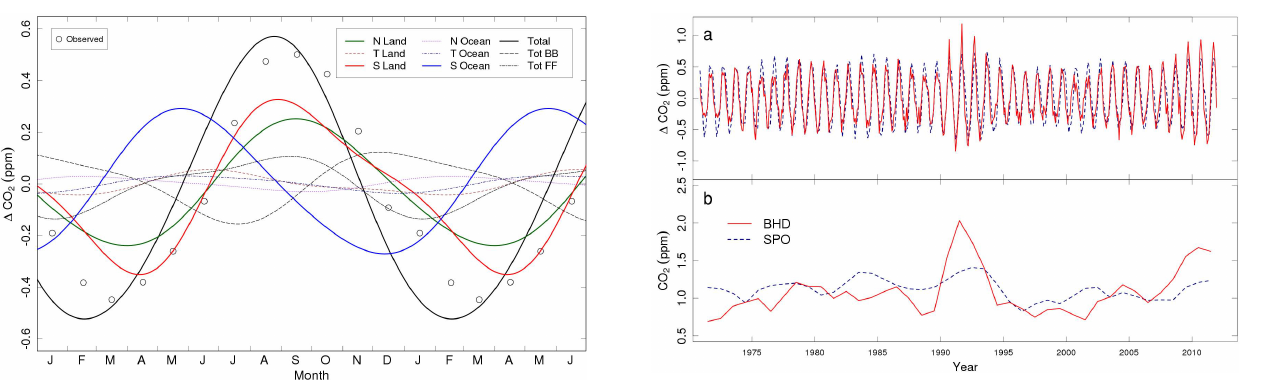
Fig. 6. Contributions to the seasonal CO 2 cycle at Baring Head as simulated by TM3 forced by CarbonTracker 2010 fluxes (Peters et al., 2007). 18 months are shown with Jan–Jun repeated for clar- ity. The northern (N), tropical (T), and southern (S) allocations are based on the TransCom regions (Gurney et al., 2003) with tropi- cal divisions at approximately 15 ◦ N and 15 ◦ S. Total contributions from biomass burning (BB) and fossil-fuel emissions (FF) are also shown. The observed cycle from Fig. 5 is plotted again here for comparison to the total model curve.